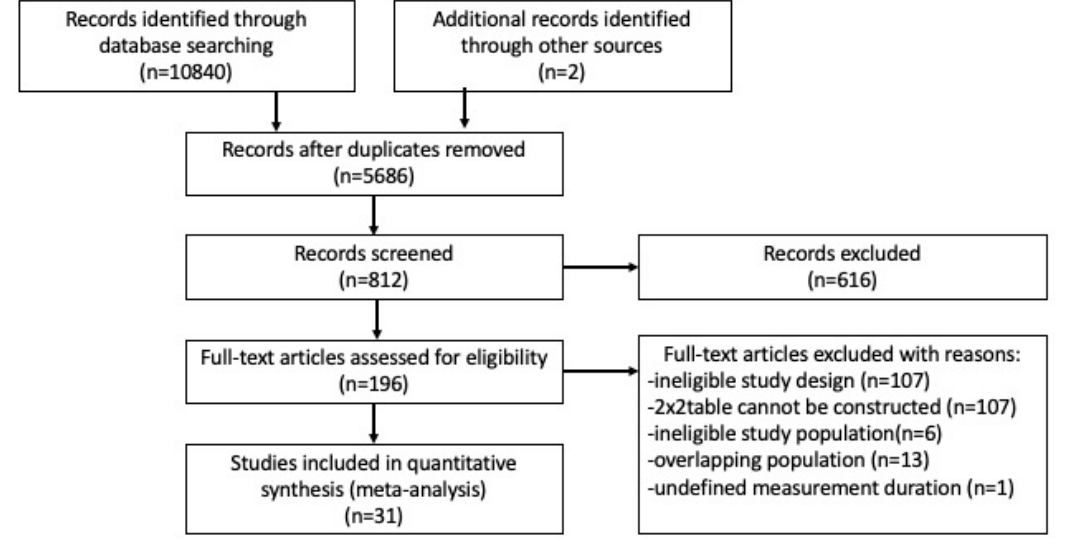
Figure 1. Preferred Reporting Items for Systematic Review and Meta-Analysis (PRISMA) flowchart showing the literature search and study selection process, finding 31 relevant studies. The two articles labeled as “identified through other sources” were located by manually evaluating articles citing and cited by studies included in our review. Study and participant eligibility was applied as defined in the methods section of the article.